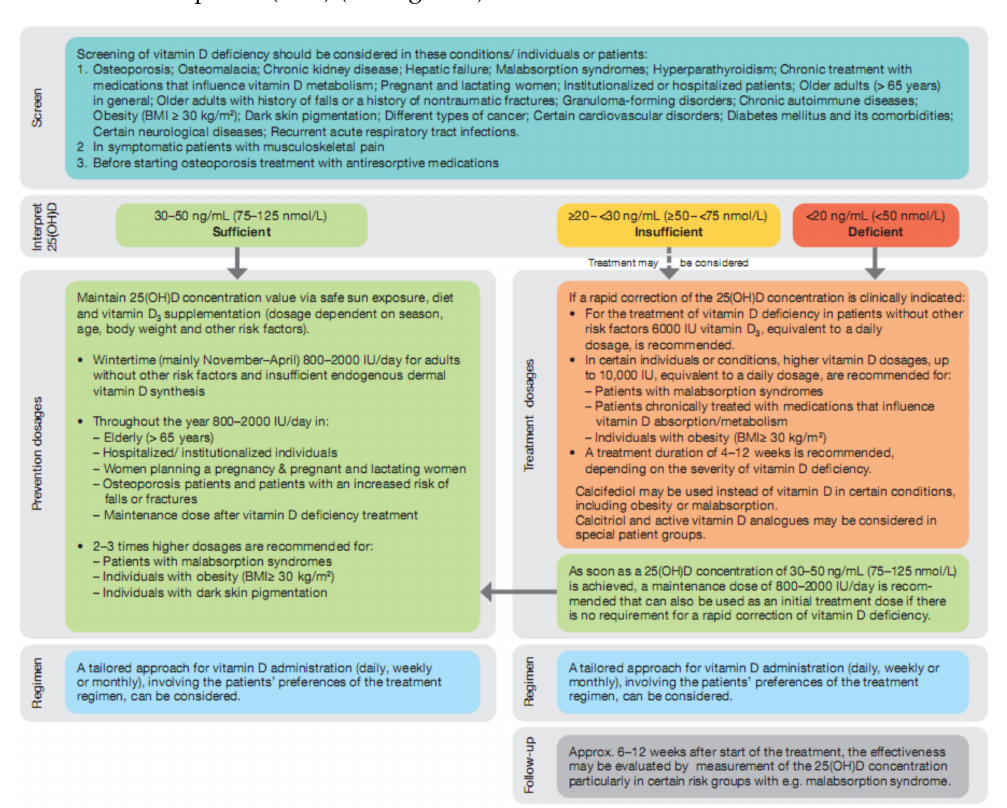
Figure 1. Algorithm for vitamin D deficiency screening and